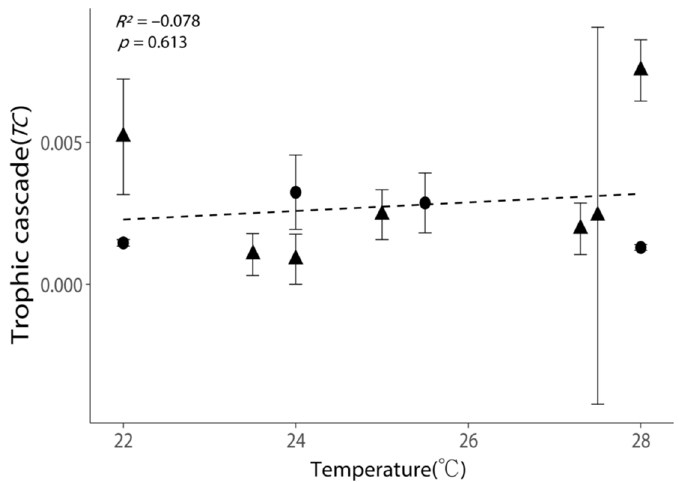
Figure 6. Relationship between the intensities of trophic cascades ( TC ) and the incubation temperatures. All values are shown as the mean ± 1 standard error. Negative values of TC were removed, as these experiments exhibited no trophic cascade. Triangular points indicate the TC calculated from the incubations with phytoplankton growth (Figure S2). The dash line indicates the best-fit regression line.